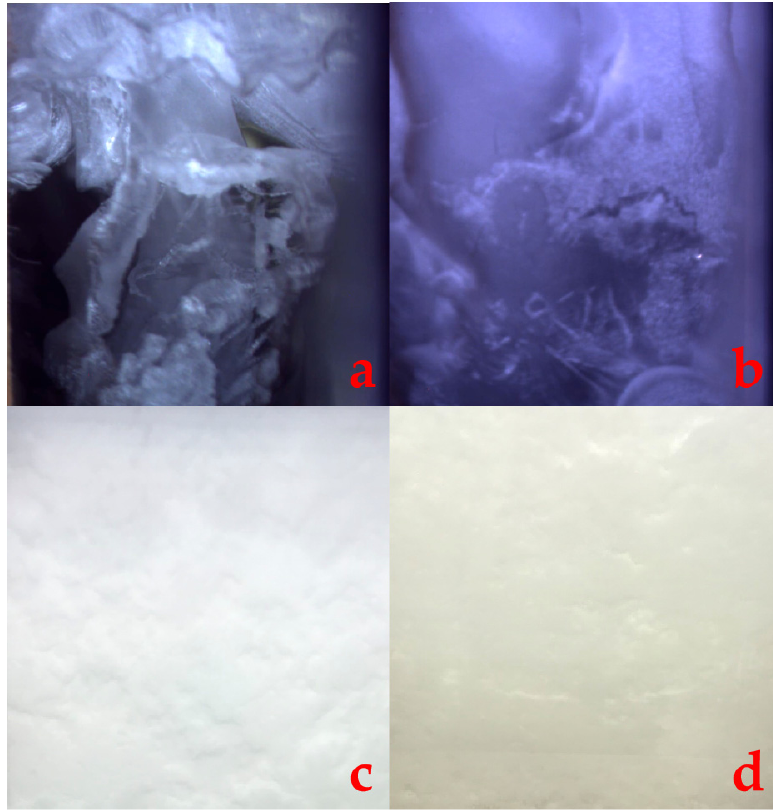
Figure 3. CO 2 hydrate morphology formed in different systems ( a ): PW; ( b ): SS; ( c ): SG/PW; ( d ): SG/SS).